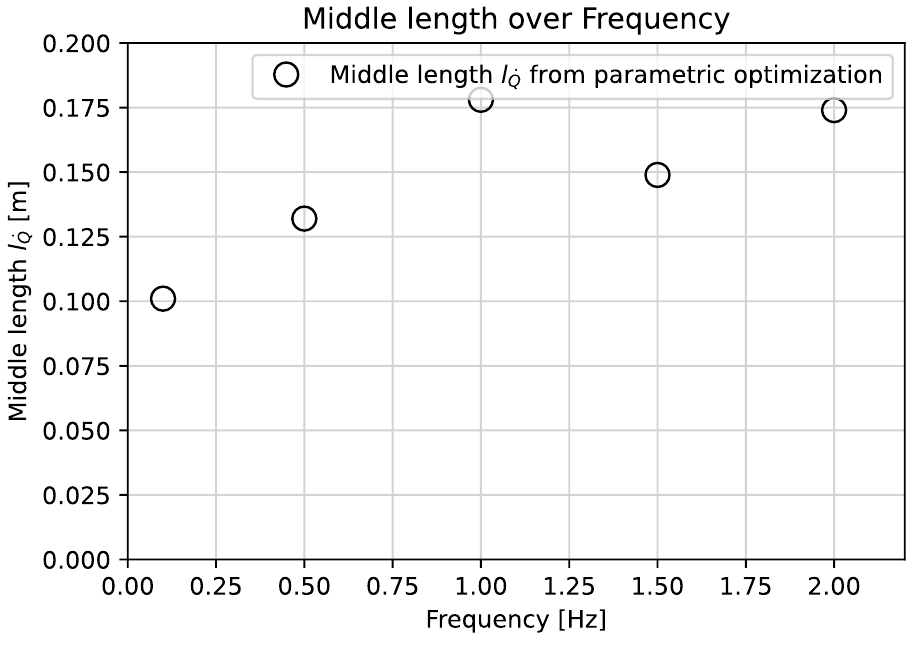
Figure 11. Resulting l ˙ Q from the optimization over the frequency f .